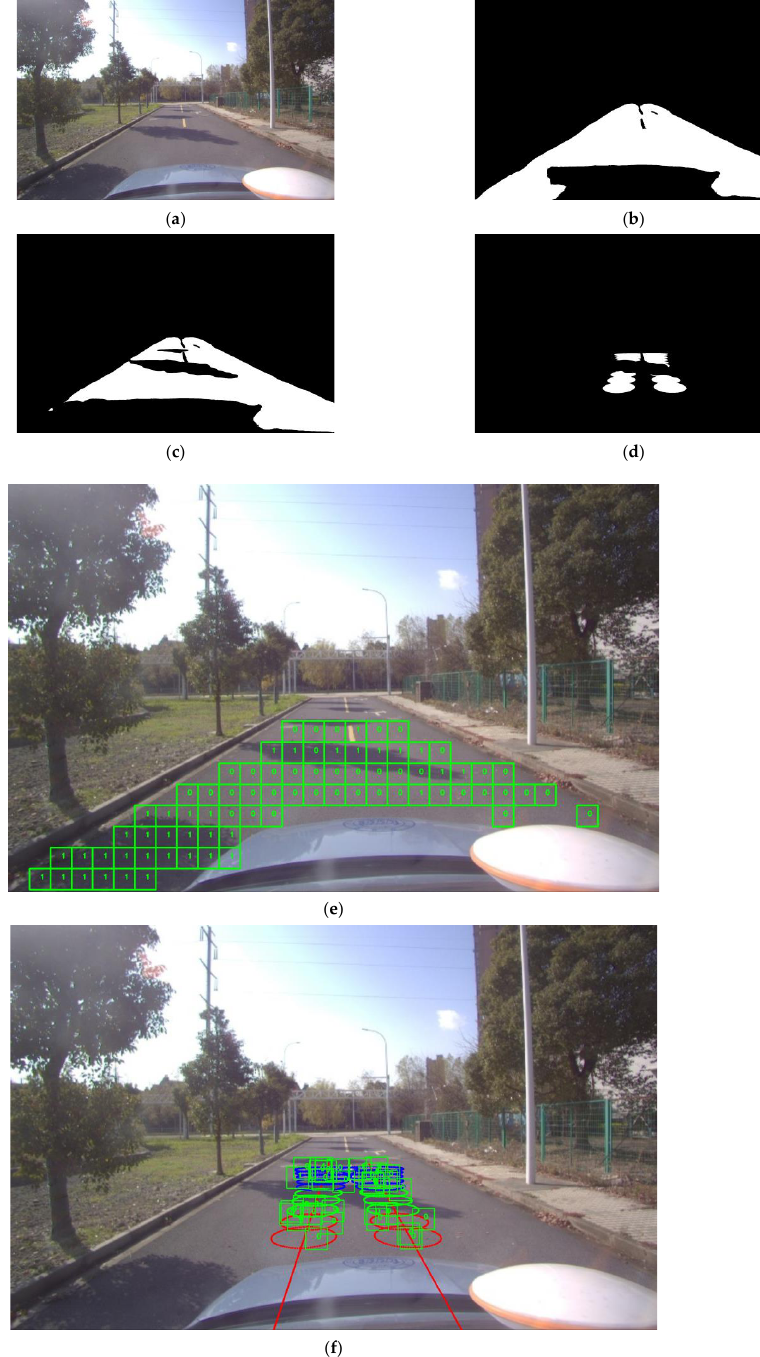
Figure 15. Example of the test results under the scenario with environmental interference. ( a ) Input image with environmental interference; ( b ) Drivable area mask; ( c ) Drivable area mask after remov- ing road shadow; ( d ) Confidence ellipse region mask after removing road shadow; ( e ) Classification results of the IE based on the voting strategy; ( f ) Classification results of the IFE. (“0”, “1” and “2” represent dry, wet and snow/ice asphalt road, respectively.).